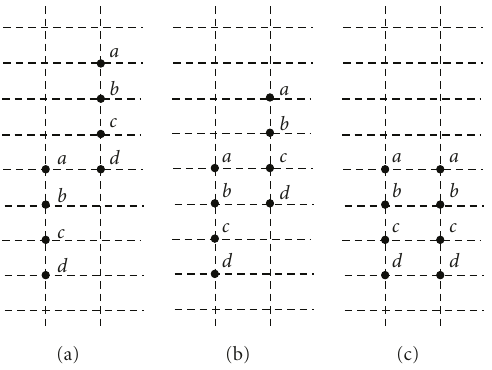
Figure 20: Alignment process of two range profiles for the global range alignment algorithm.